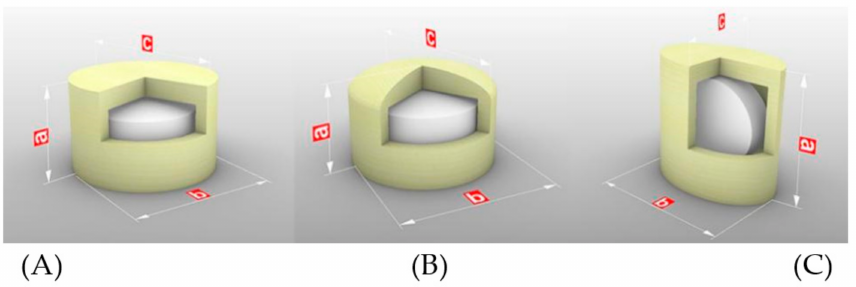
Figure 1. 3D-printed tablets with different geometric structures: ( A ) FH-95-266, ( B ) CH-95- 266, ( C ) FU-95-266. a, b and c represent the hight, diameter/major axis and minor axis of tablet, respectively.